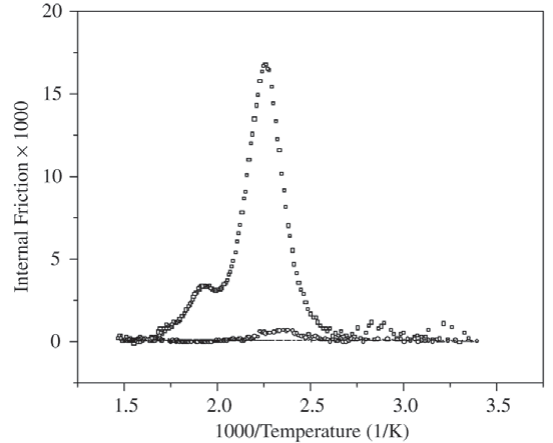
Figure 3. Internal friction as a function of temperature for